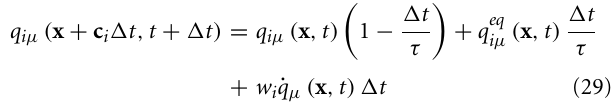
coordinates, three angles and the corresponding three angular